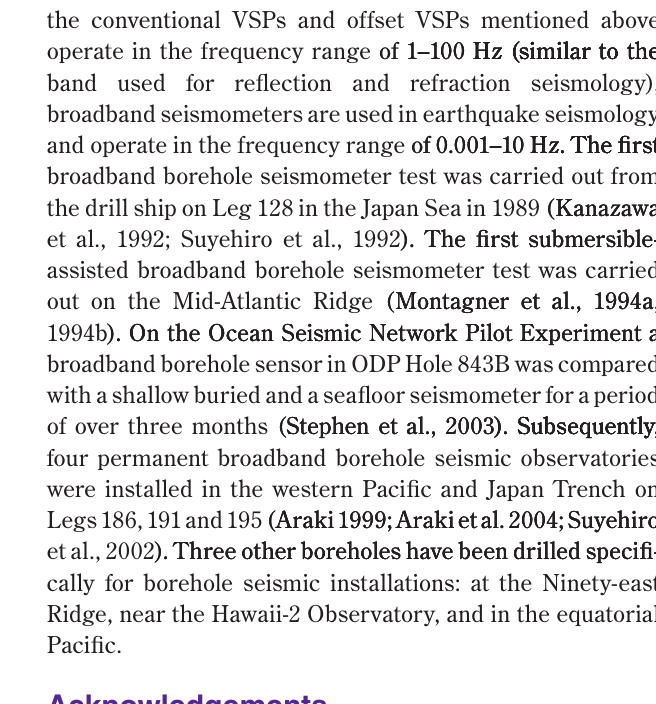
Figure 2. In the Wireline Re-entry System, a borehole sonde, data recording package, and control vehicle are suspended from a conventional research vessel on coaxial or fiber-optic cable (left). The control vehicle, navigated within a network of acoustic transponders, is used to guide the sonde into the borehole. The sonde is lowered into the borehole until the data recording package lands in the re-entry cone (right). When the seafloor and subsea- floor systems are operating properly, the control vehicle is disconnected from the data recoding package and is recovered back onboard the ship. The borehole system acquires data autonomously for up to a year until the system is recovered by grappling. From Stephen, et al.,